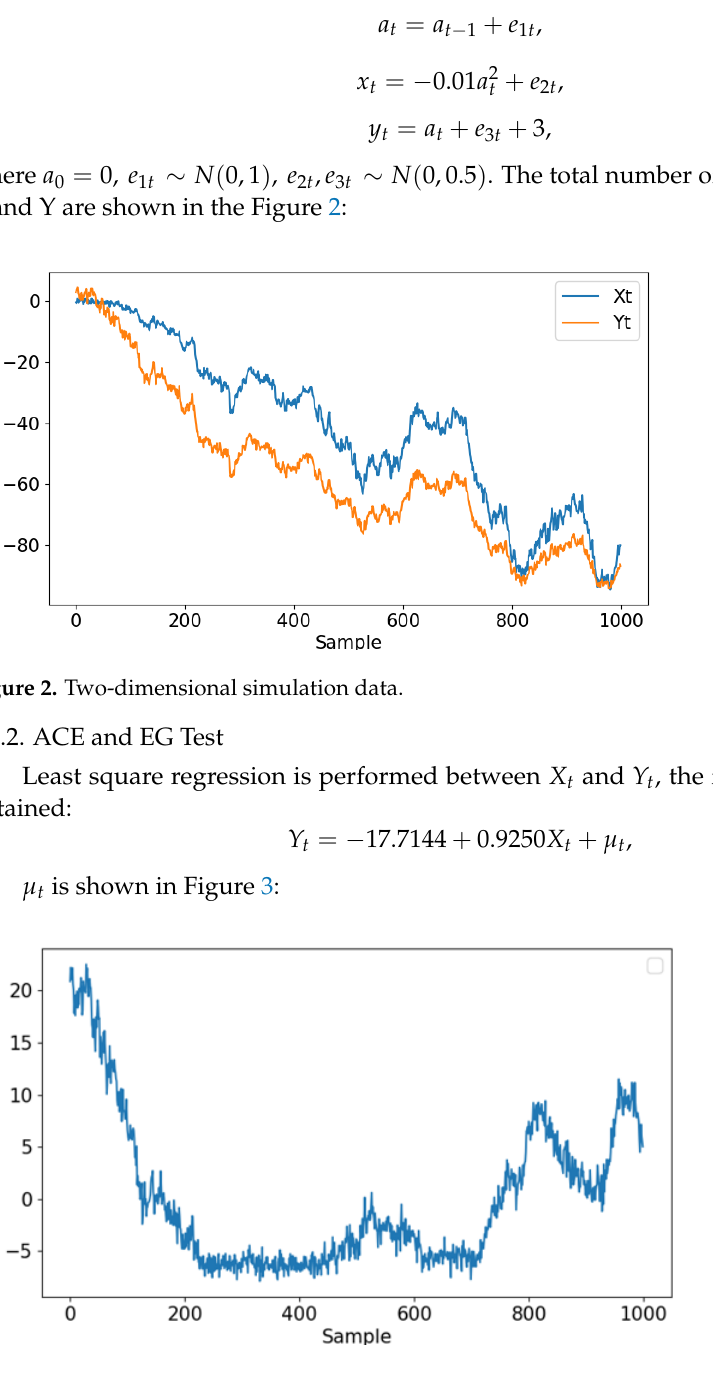
Figure 3. Residual sequence of raw data.